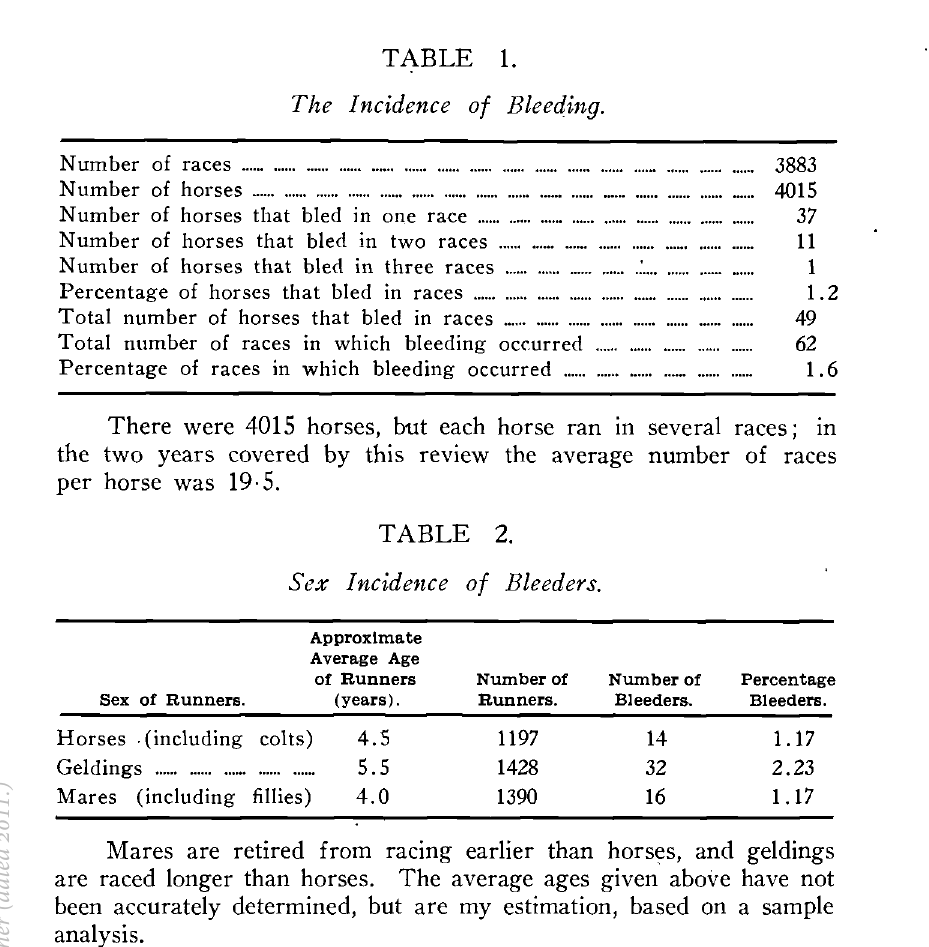
The Incidence of Bleeding.